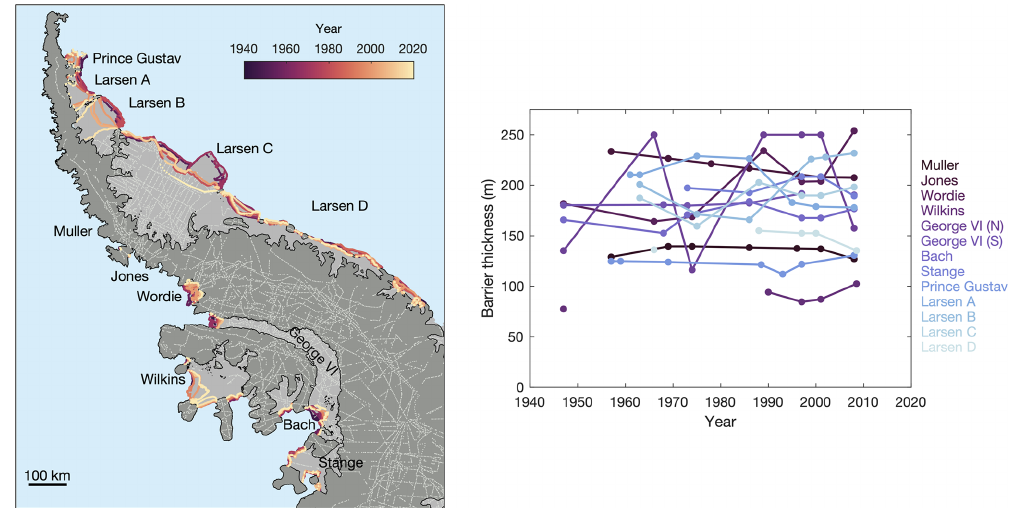
Figure 3. Change in Antarctic ice shelf barrier position (left) and thickness (right) over time. Barrier positions are derived from episodic satellite imagery (Cook and Vaughan, 2010), and barrier thicknesses are derived from airborne ice penetrating radar (light grey lines) and satellite radar altimetry (Fretwell et al., 2013). Iceberg calving is calculated as the difference in area between successive barrier